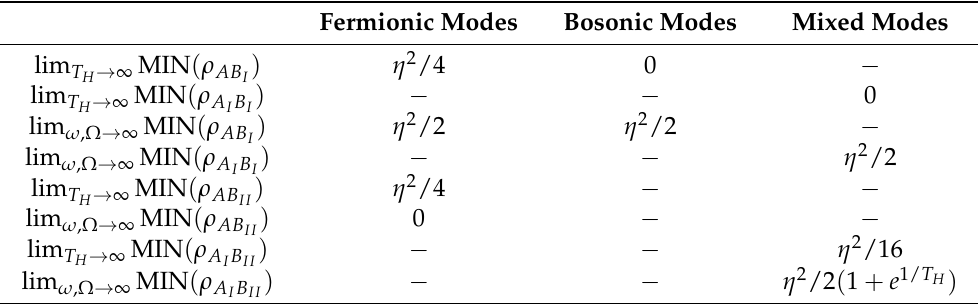
Table 1. The limits of the measurement-induced nonlocality (MIN) for the accessible and inaccessible correlations in the case of the fermionic, bosonic and mixed modes. In the table, T H stands for the Hawking temperature, ω ( Ω ) is the fermionic (bosonic) frequency and η denotes the entanglement parameter. The regions are described in detail in the main